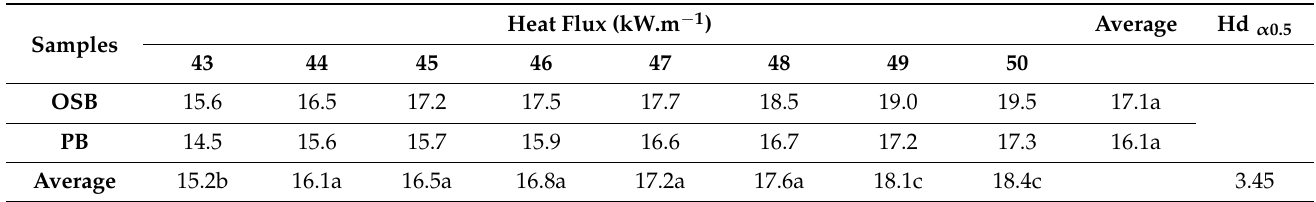
Table 5. The impact of samples (PB, OSB) and impact of thickness (12.15 and 18 mm) on the time-to- ignition through the 1-factor analysis of variance (ANOVA) ( α =